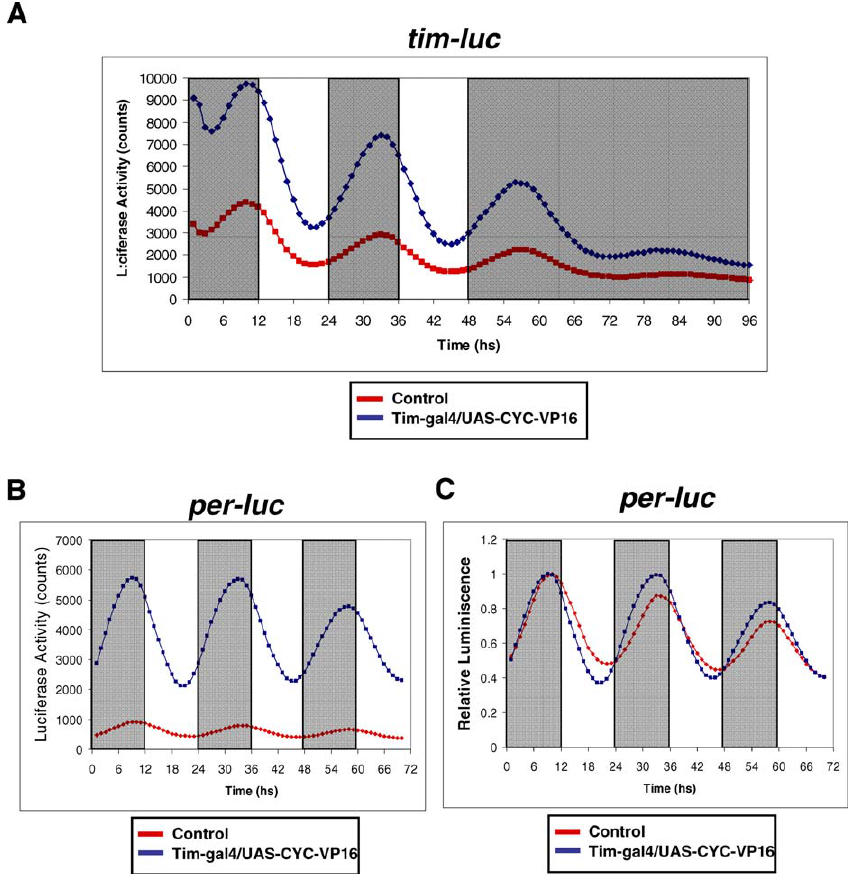
Figure 3. Expression of cyc - vp16 Affects CLK-Mediated Transcription in Cultured Fly Wings (A) Luciferase recordings from control ( uas - cyc - vp16 / þ ) and tim - cyc - vp16 flies using the tim - luc reporter. Light timing is indicated by alternating white and gray background areas, with white representing the illuminated interval of LD (ZT0–12) and gray representing the dark period (ZT12–24). After 3 d in LD conditions the assay was conducted in DD conitions. The results are the average of ten ( tim - cyc - vp16 ) and 13 (control) pairs of fly wings. (B) Luciferase recordings from control ( uas - cyc - vp16 / þ ) and tim - cyc - vp16 flies utilizing the per - luc reporter. The results are the average of 24 pairs of fly wings of each genotype. (C) Both curves in (B) were normalized to their maximum and then plotted